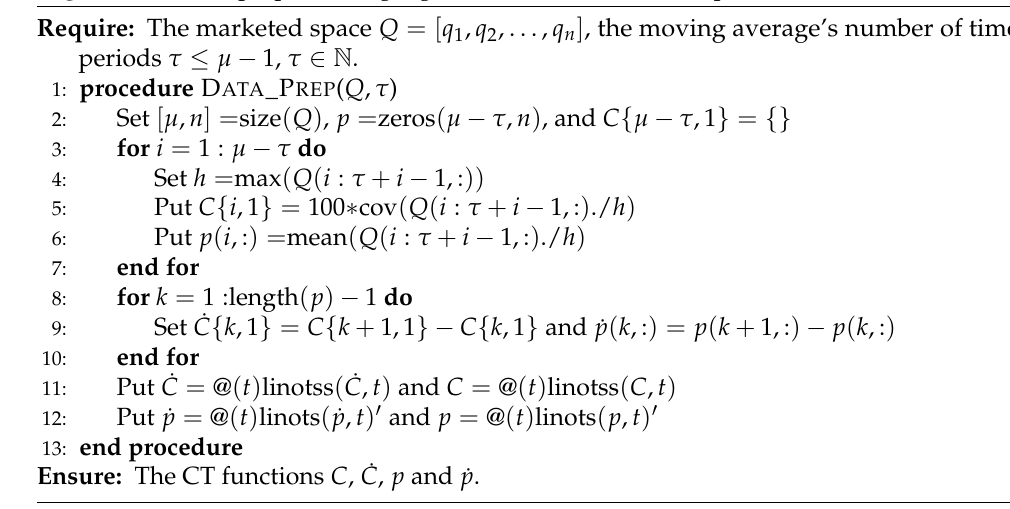
Algorithm 1 Data preprocessing algorithm for the CT MVPO